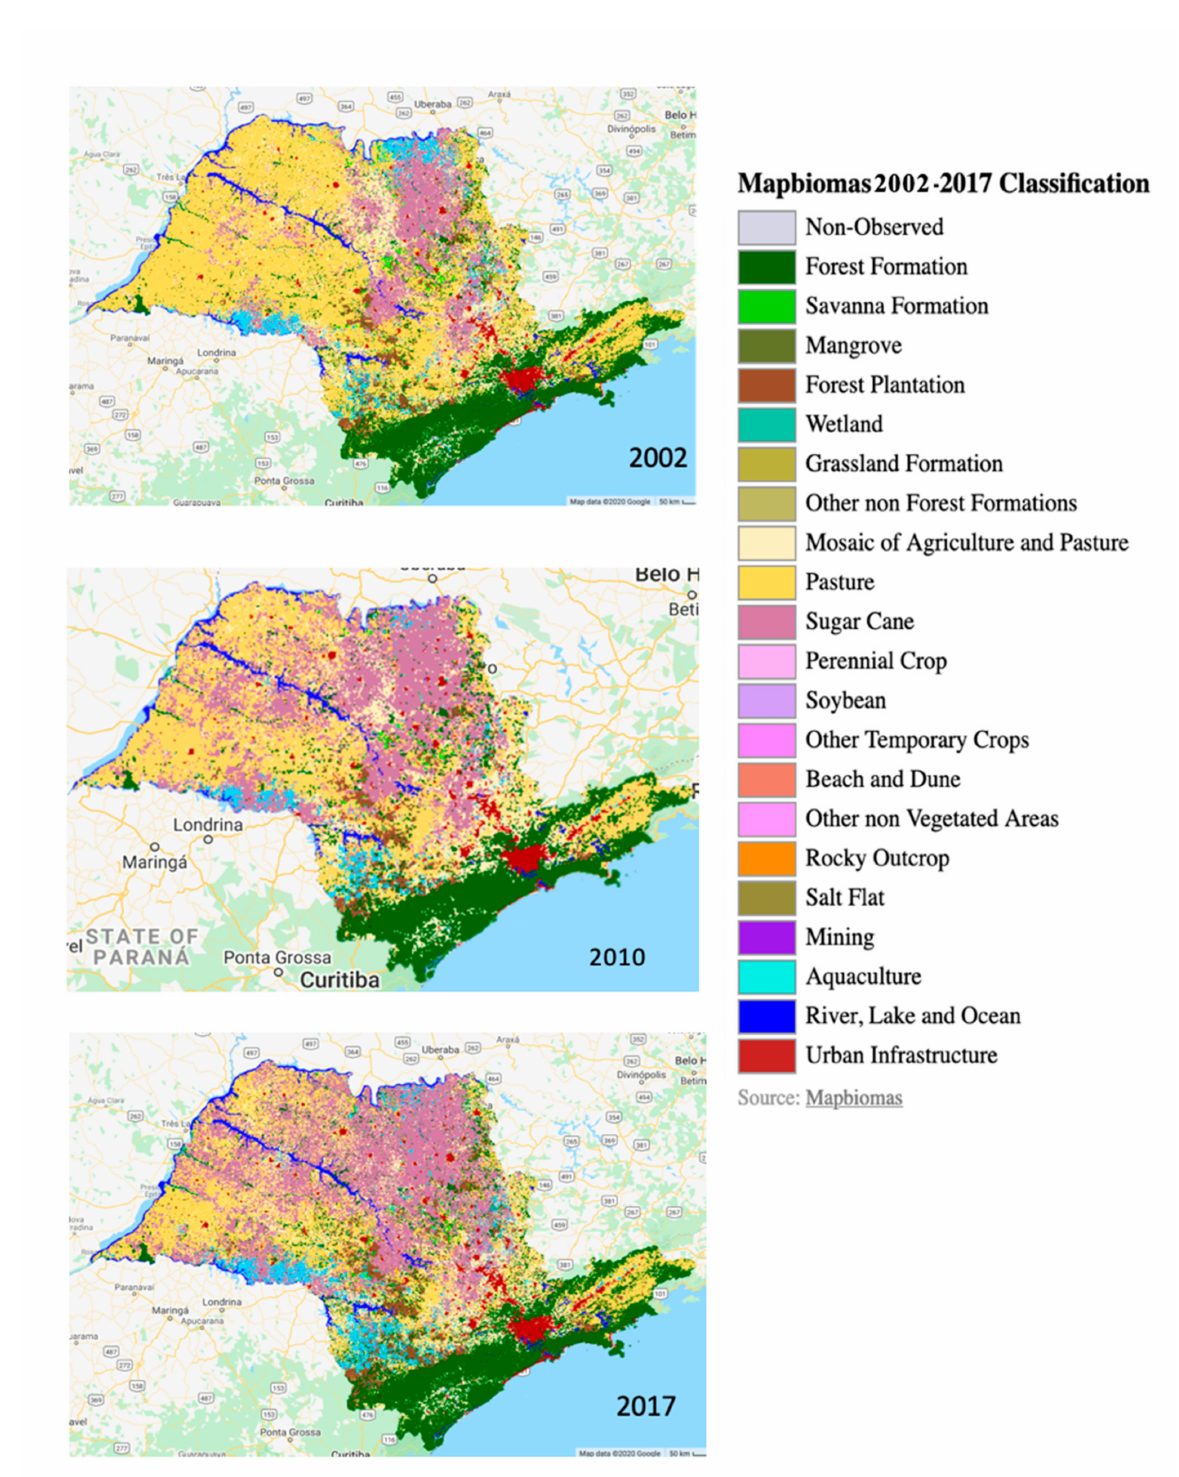
Figure 4. Land use classification in S ã o Paulo, Brazil, in 2002: ( top ), at the start of the study period, 2010 ( middle ), at the midpoint of the study period, and 2017 ( bottom ), at the end of the study period. Classes and palette are from the original MapBiomas data